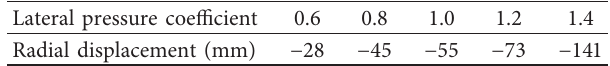
Figure 4: Cloud chart of stress distribution in the vertical section of the shaft wall (unit: MPa). Table 2: Results of shaft coal pocket wall displacement test (measuring point